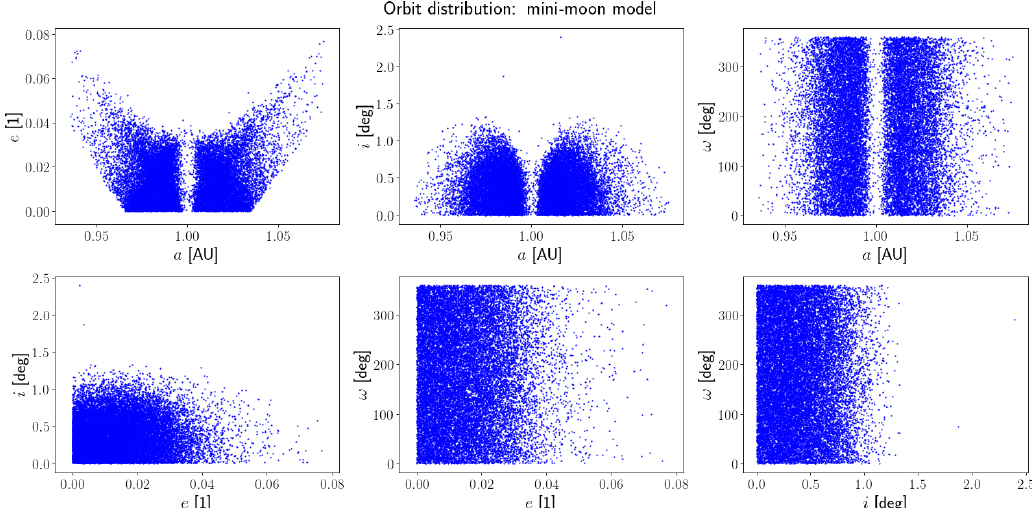
Figure 2. Orbital elements of the synthetic mini-moons in the heliocentric J2000 frame. This is the initial distribution for the mini-moon simulations. We have not illustrated the longitude of the ascending node as this will be closely related to the temporal distribution of